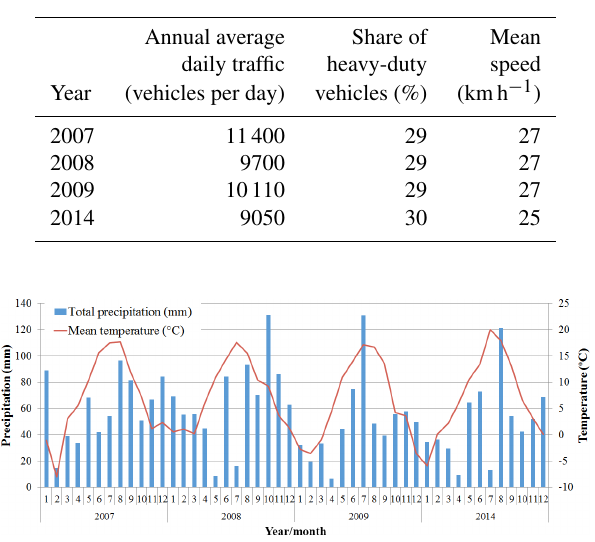
Table 1. Summary of traffic data at Hämeentie for four years.